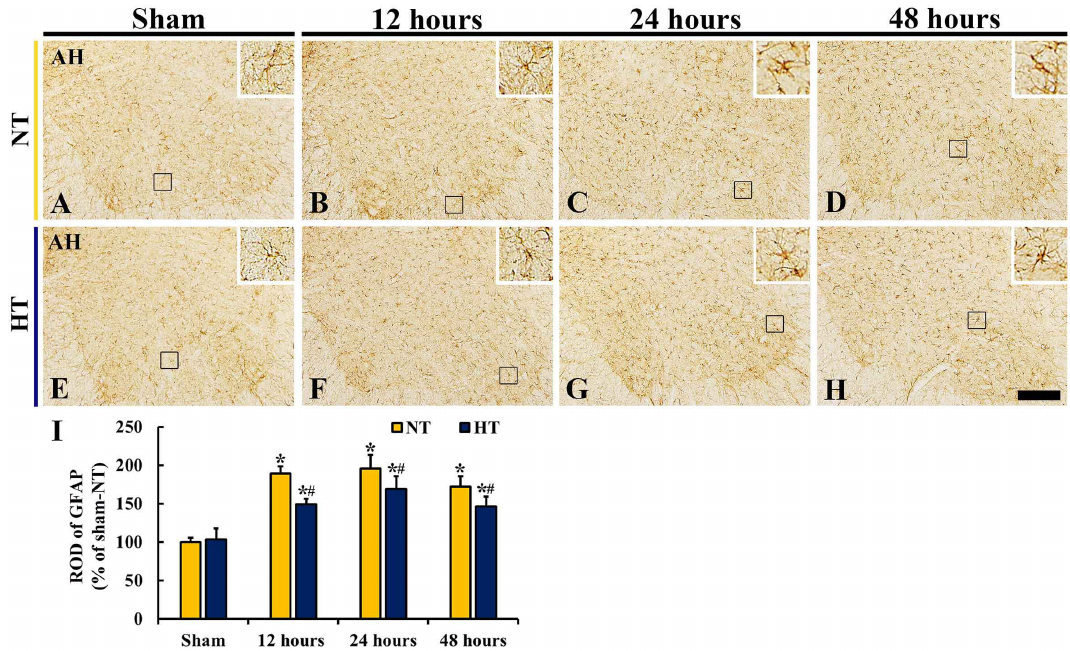
Figure 9. ( A – H ) GFAP immunohistochemistry in the anterior horn of the sham-NT ( A ), CA-NT ( B – D ), sham-HT ( E ), and CA-HT ( F – H ) groups at 12 ( B , F ), 24 ( C , G ), and 48 ( D , H ) hours after CA/ROSC. In both CA-NT and CA-HT groups, GFAP + astrocytes react to ischemic insult (enlarged cell bodies and thickened processes); GFAP immunoreactivity of the CA-HT group is lower than that of the CA-NT group. Note that damages of GFAP + processes (boxes of C , D , H ) is apparent at 24 and/or 48 h after CA/ROSC. AH, anterior horn. Scale bar = 200 µm. (I) ROD of GFAP + structures. The bars indicate the means ± SD ( n = 6, respectively; * p < 0.05 vs. each sham group; # p < 0.05 vs. corresponding CA-NT group).